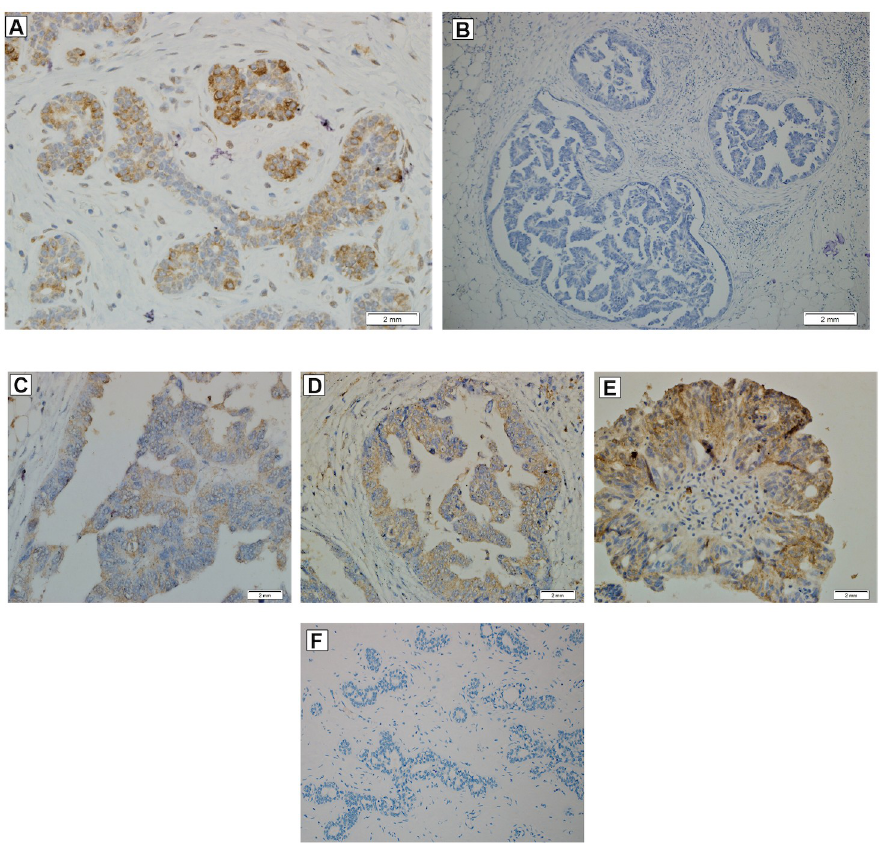
Fig 4. Immuno-histochemical staining using the PRLR antibody in ovarian cancer tissue. (A) Breast tissue section shows moderate intensity of cytoplasmic staining with PRLR antibodies and was used as positive control. (B) OC tissue section with negative staining for PRLR expression. Grade of staining in OC tissue sections according to staining percentage, (C) Mild ( < 25% of the section area) level (D) Moderate (25–50% of the section area) level (E) High-grade ( > 50% of the section area) level. (F) Breast tissue section with negative staining for PRLR expression.